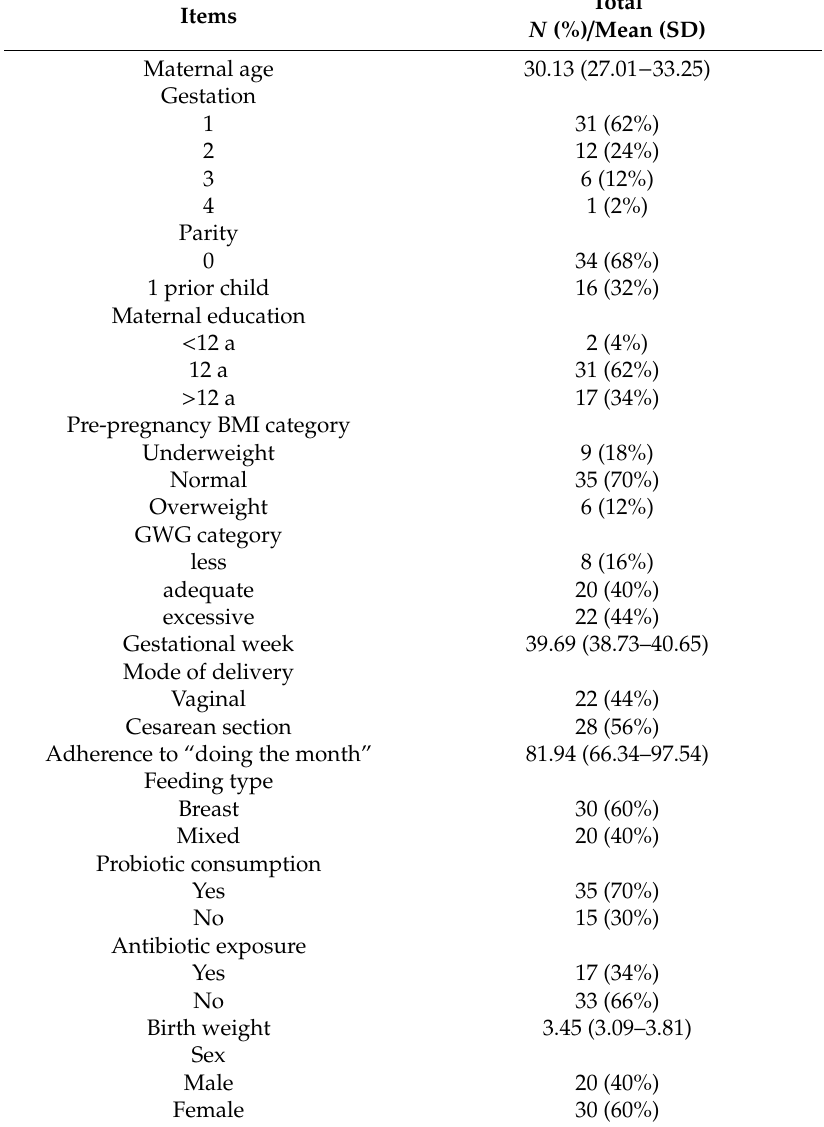
Table 1. Demographic and birth characteristics of infants ( n =